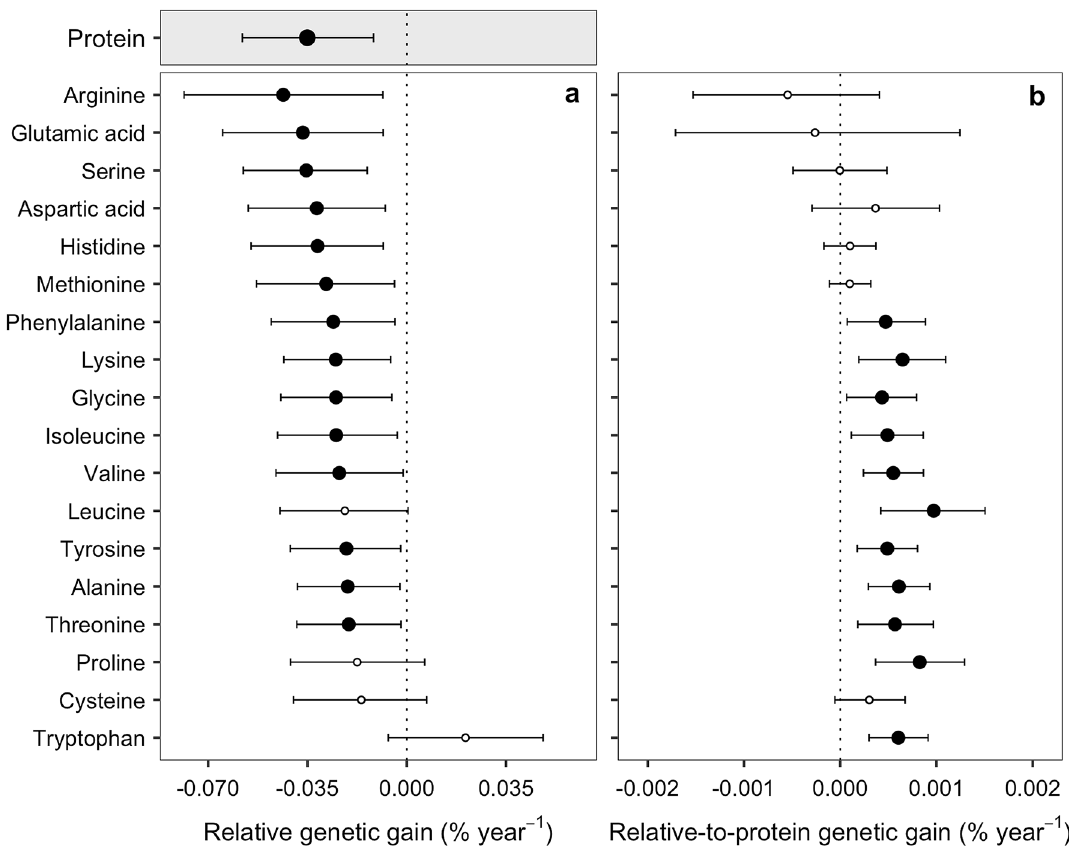
Figure 3. Relative genetic gain of protein and amino acid concentrations ( a ) and the relative-to-protein genetic gain of amino acid concentrations ( b ), calculated from 13 soybean genotypes released from 1980 to 2014 period. Points represent the medians of bootstrapped distribution with their respective 95% confidence intervals (small horizontal lines). Black solid points represent the AAs with significant relative gains, whereas the empty points are non-significant (95% CI including